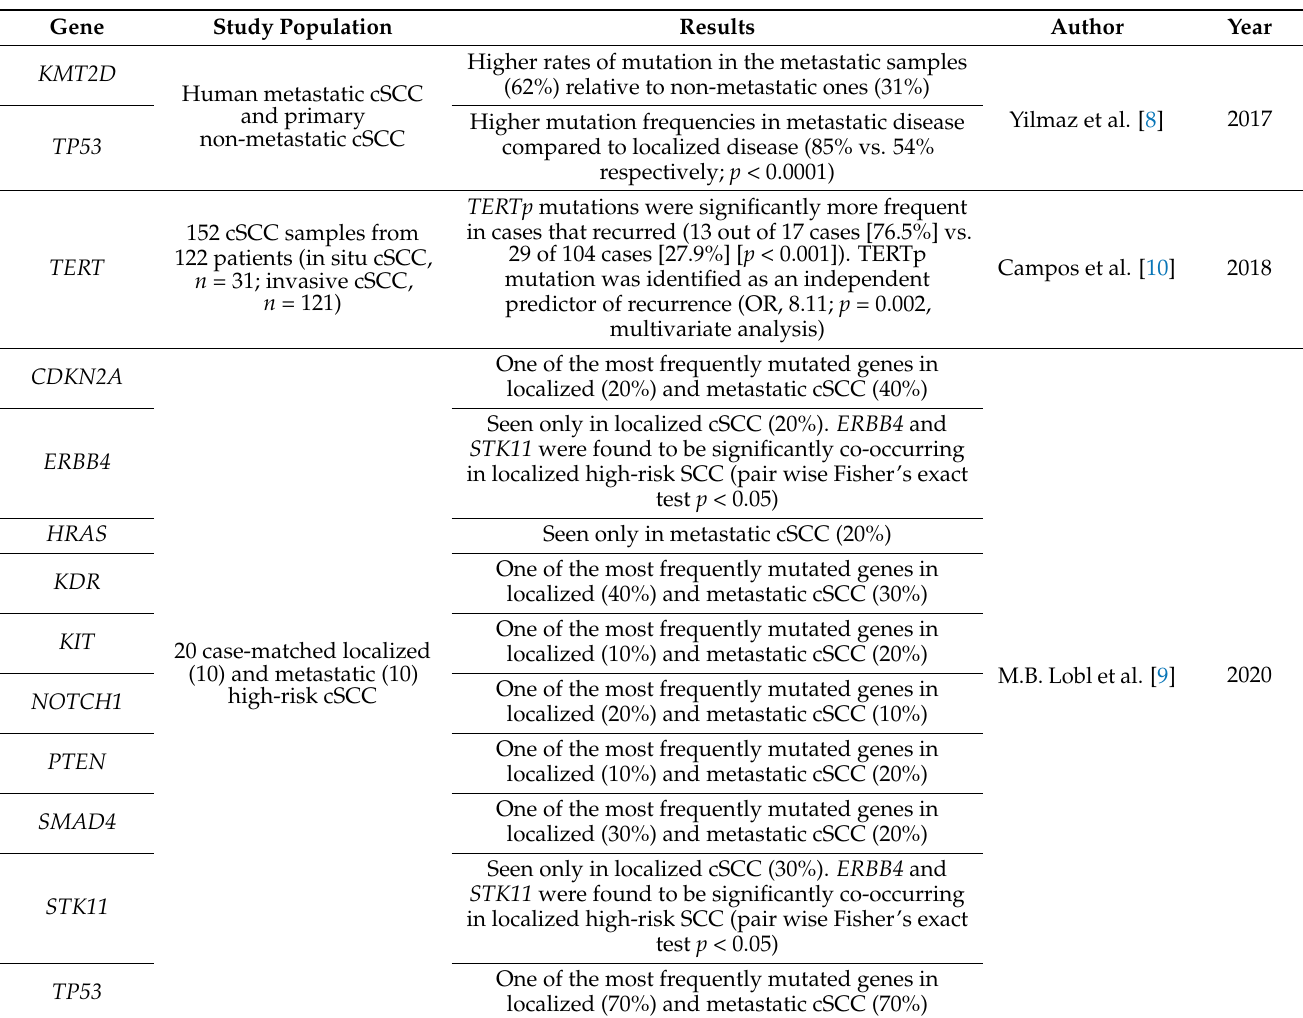
Table 2. Genes involved in